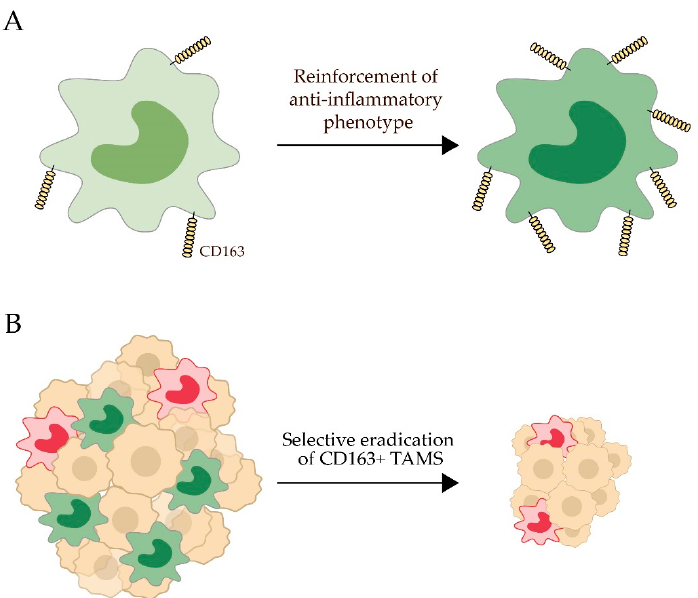
Figure 3. Selective targeting of CD163 + macrophages in inflammatory and cancer therapy. ( A ) The anti-inflammatory e ff ects of CD163 + macrophages are reinforced by either high dose free dexamethasone or low dose CD163 targeted dexamethasone delivery system. High dose free dexamethasone carries a number of systemic side e ff ects, including lymphocyte apoptosis that can be avoided by low dose dexamethasone targeting. ( B ) Selective eradication of CD163 + macrophages entail suppressed tumor growth and reduce metastatic spread in animal